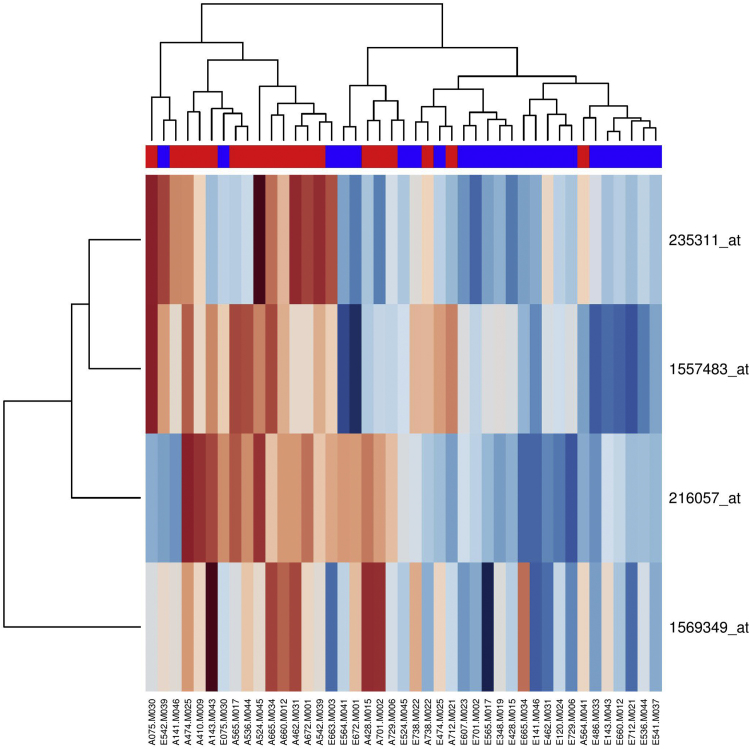
Heatmap and dendrogram of the differential gene expression profiles for the four gene markers generated from unmatched pre-HEP and post-HEP intervention samples using MAS5.0 normalization before FDR correction. The pre-intervention group is colored in blue and post-intervention group is in red. The relative expression level of each gene among all the tested samples have been assigned sequentially from dark red color to dark blue color in accordance with low to high expression level.